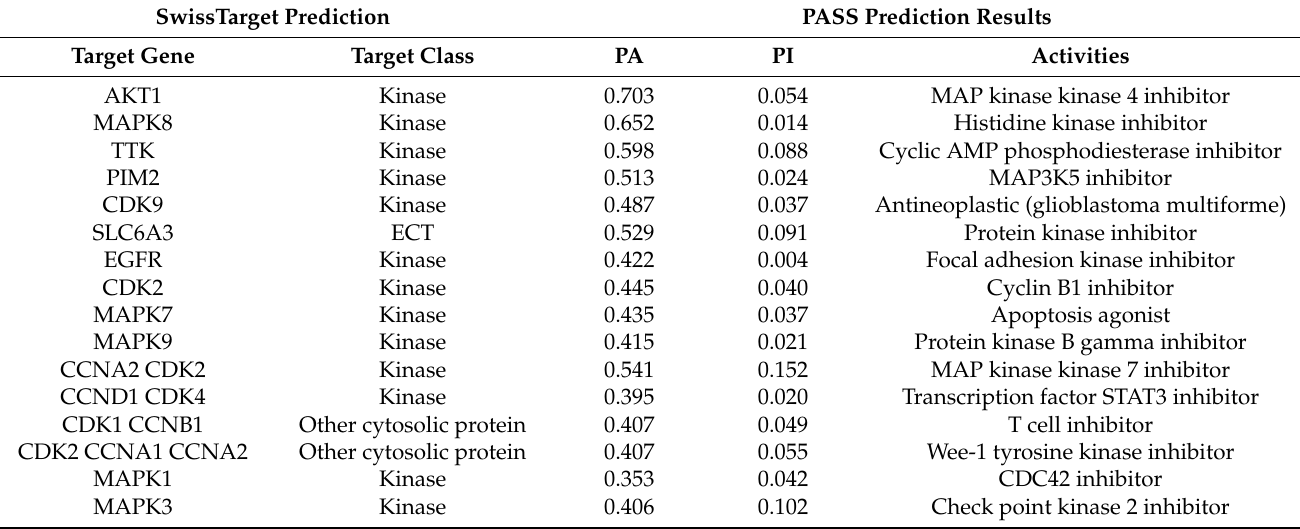
Table 1. Prediction of Biological Activity Spectra (PASS) and Swiss target genes and classes of the SJ10